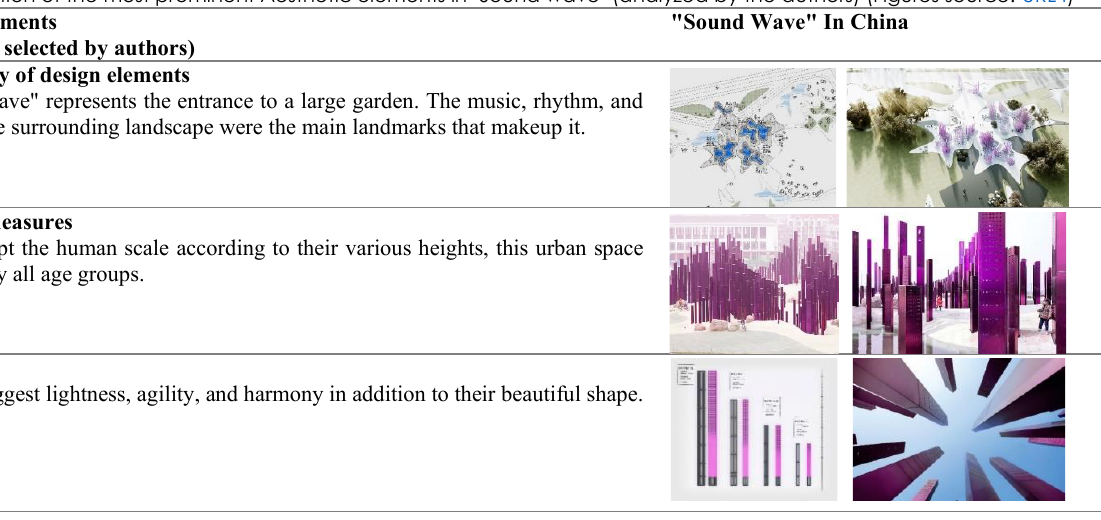
Table 2 : Selection of the most prominent Aesthetic elements in "Sound wave" (analyzed by the authors) (Figures source: URL4) Aesthetic Elements (Defined and selected by authors) The Harmony of design elements